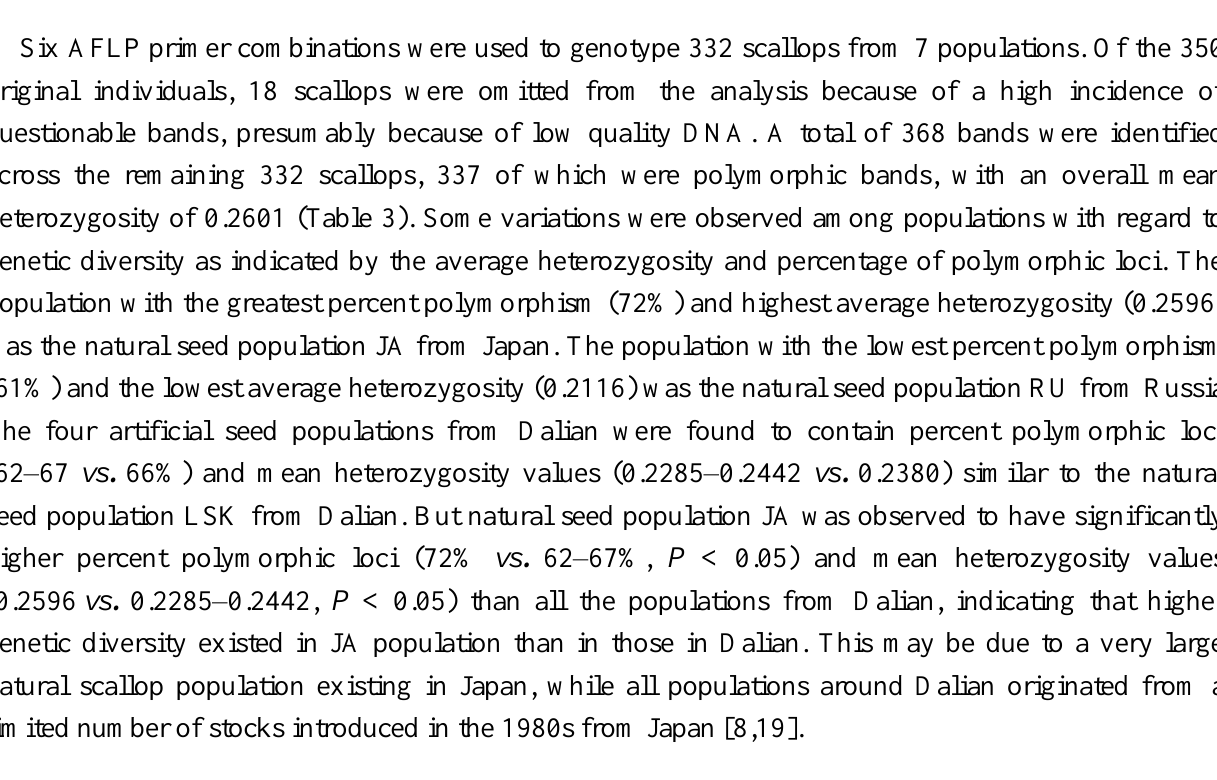
Table 3. Average heterozygosity and percentage polymorphism for Japanese scallop across 368 AFLP